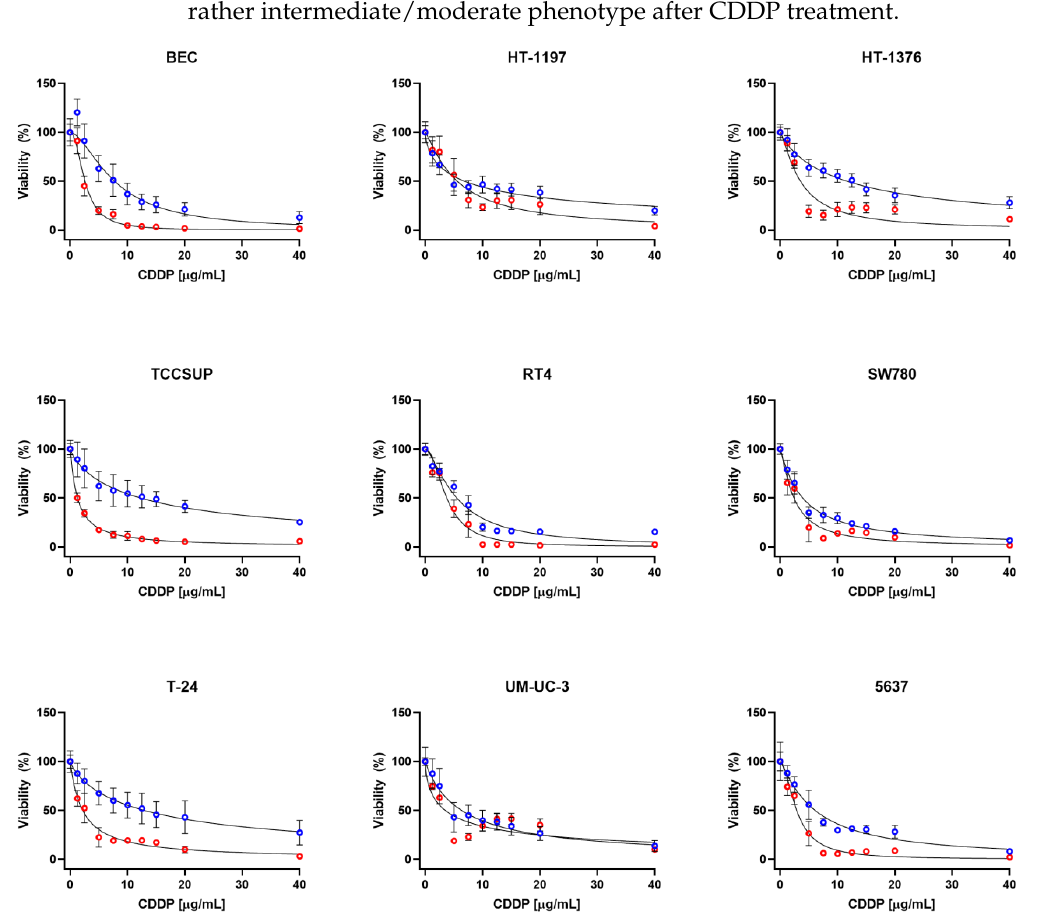
Figure 2. Viability of the UCC lines and BEC after continuous 24 (blue) and 48 (red) h CDDP exposure. Values are shown as the mean ± SD ( n = 8 of three biological replicates). Table 1. IC 50 values for the UCC lines and BEC for all CDDP treatment conditions. CDDP, cisplatin; CI, confidence interval; NA, not applicable.